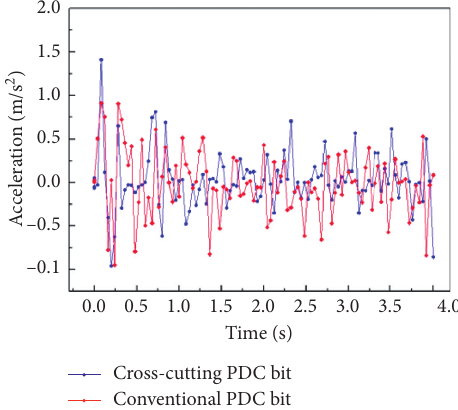
Figure 14: Acceleration response along the drilling direction.